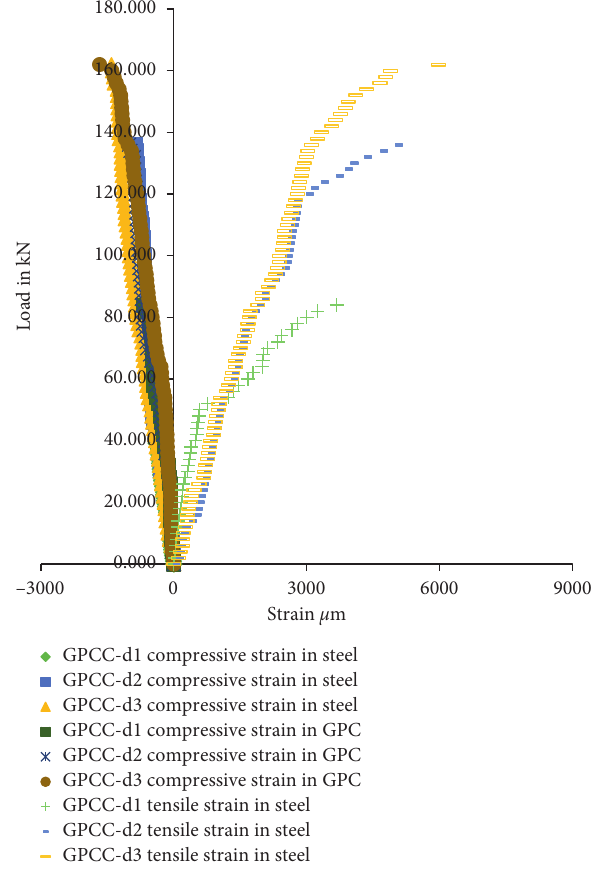
Figure 18: Load-strain behaviour of GPCC (DRB).